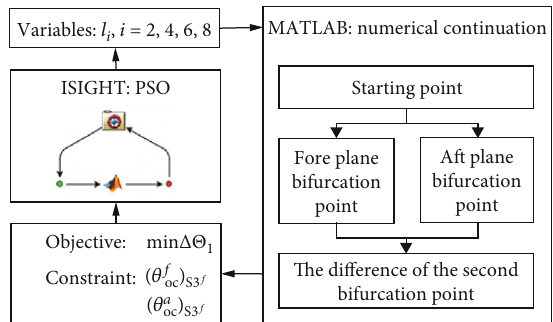
Figure 17: Computational fl ow of cosimulation-based